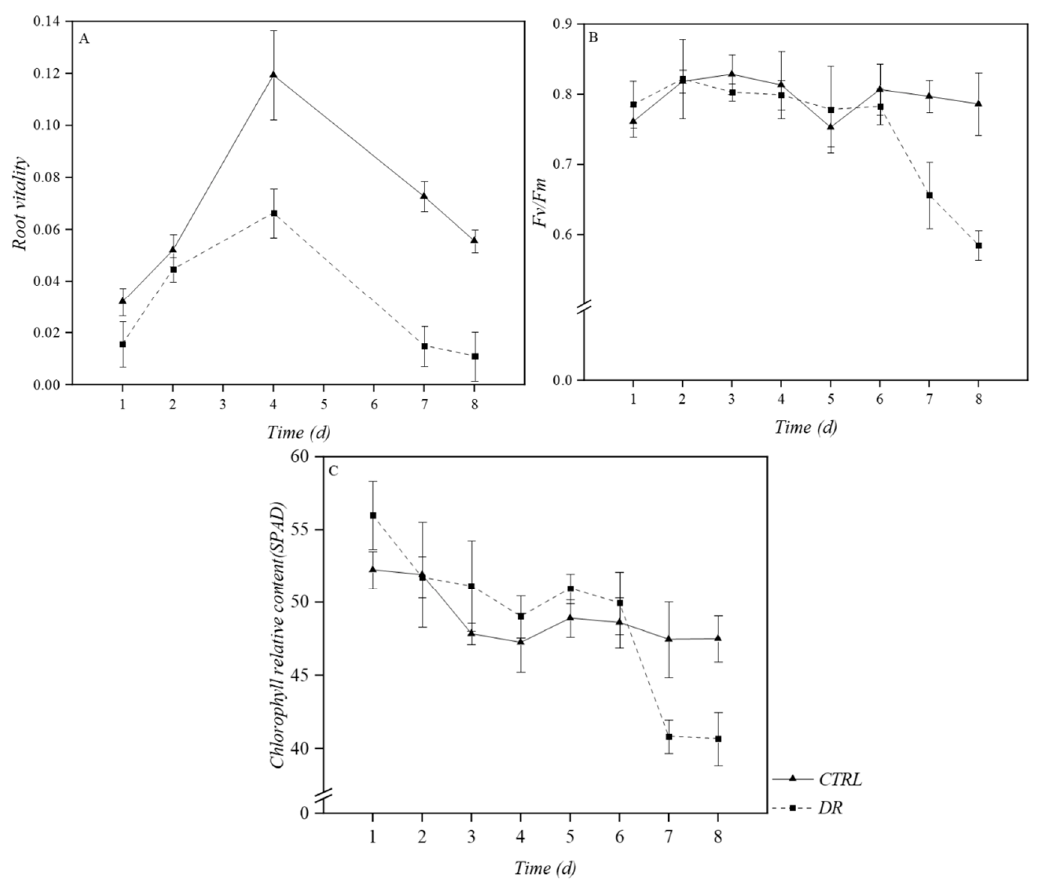
Figure 7. The change of physiological parameters during the experiment (Day 1–Day 8). ( A ) is the change of root vitality , ( B ) is the change of F v/ F m, ( C ) is the change curve of SPAD values; i.e., control (CTRL), drought (DR).